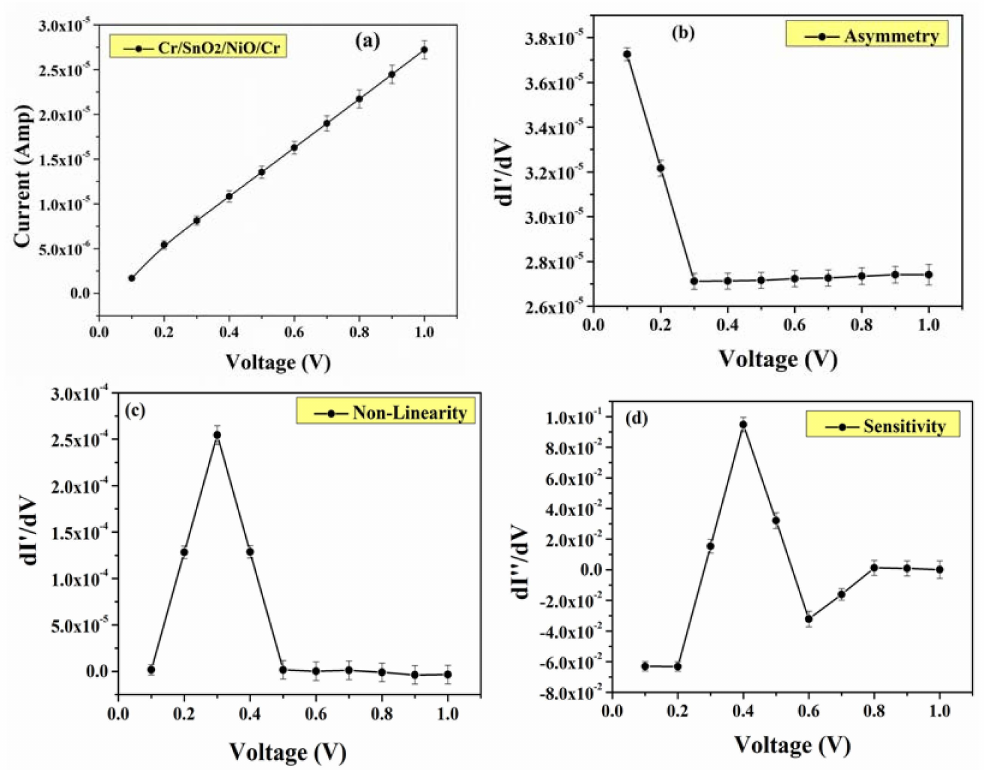
Figure 7. I-V characteristics of MIIM device (Cr/SnO 2 /NiO/Cr) ( a ). Asymmetry ( b ), Non-linearity ( c ) and Sensitivity ( d ) was derived from I-V